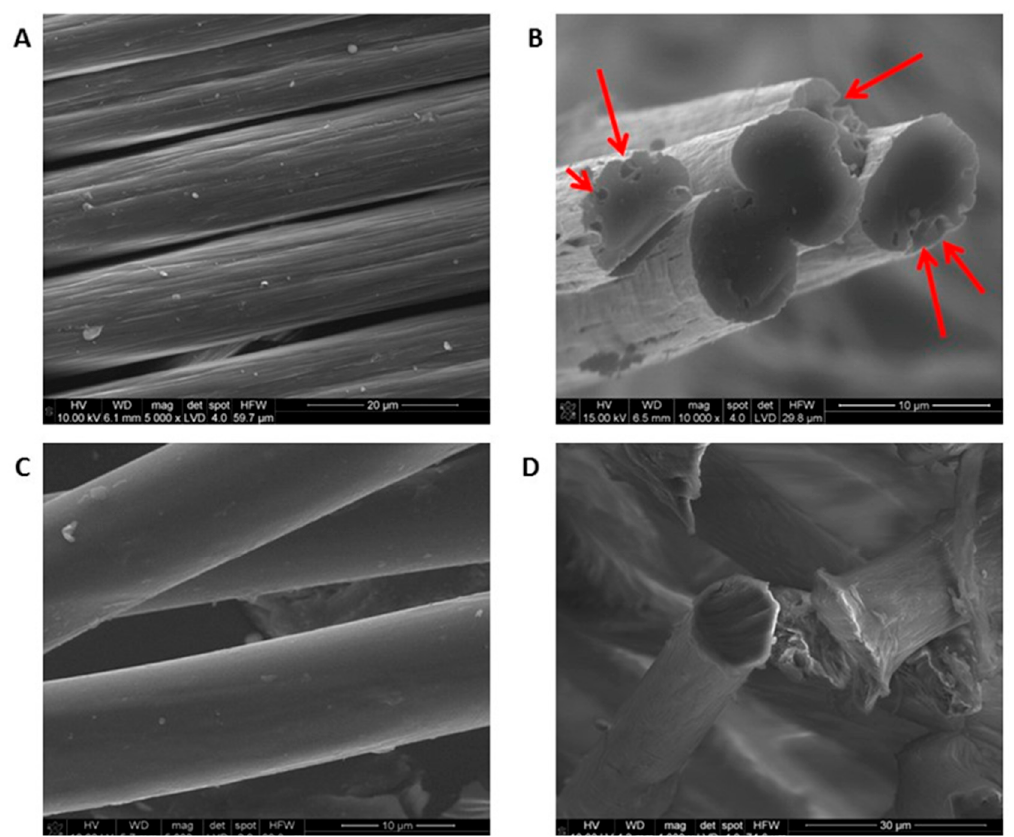
Figure 1 . SEM microphotographs of carbon fibers (CFs) and poly (lactic ‐ co ‐ glycolic acid) (PLGA): Figure 1. SEM microphotographs of carbon fibers (CFs) and poly (lactic- co -glycolic acid) (PLGA): ( A , C ) ( A , C ) fiber surfaces and ( B , D ) their cross sections . Pores are indicated with arrows. Scale bars: 10 μ m– fiber surfaces and ( B , D ) their cross sections. Pores are indicated with arrows. Scale bars: 10 µ m–30 µ m. 30 μ m.